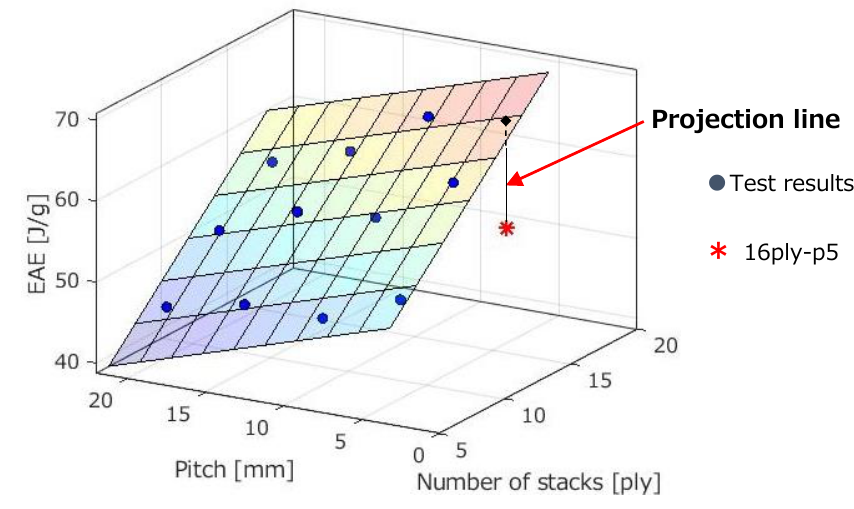
Figure 17. Response surface and test results (EAE).